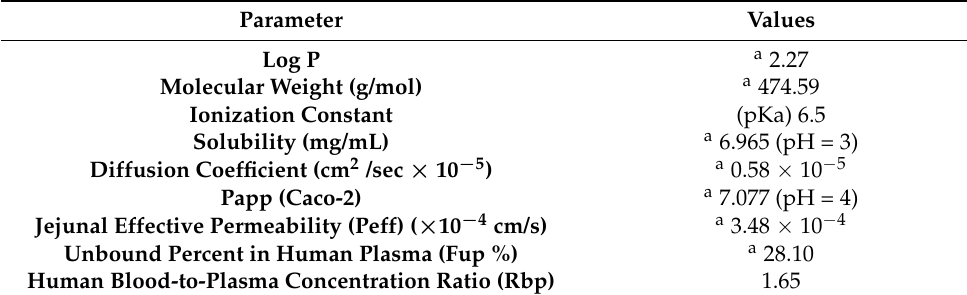
Table 2. Physicochemical and biopharmaceutical values of Viagra ® 50 mg obtained from ADMET